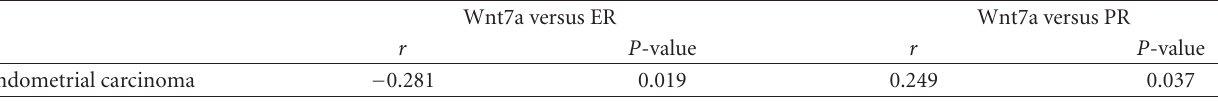
Table 3: Correlation between Wnt7a and ER/PR in endometrial carcinoma.